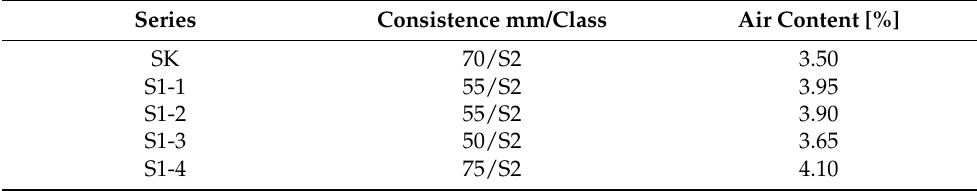
Table 3. Consistency class and air content in concrete mixtures subject to tests. Series Consistence